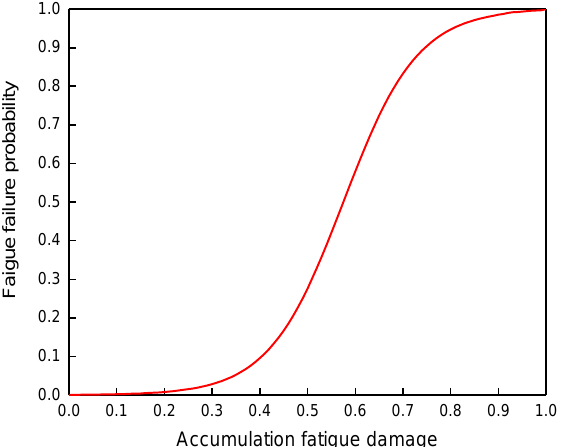
Figure 14. Relationship between the fatigue failure probability and accumulation fatigue damage.